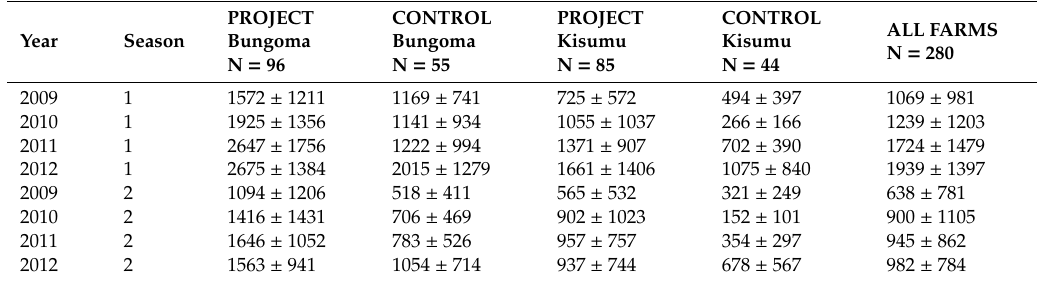
Table 1. Maize yield (kg ha − 1 ) for all project and control farms (measured on field level) in Bungoma and Kisumu. Values are mean ± standard deviation for all four years (2009–2012) and both seasons (1 and 2); n = number of farms included in the